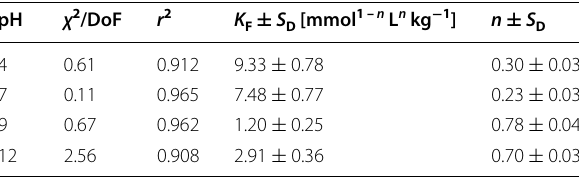
K F , Freundlich constant; n , Freundlich exponent; S D , standard deviation; χ 2 / DoF, probability distribution normalized to the number of data points; r 2 , determination coefficient